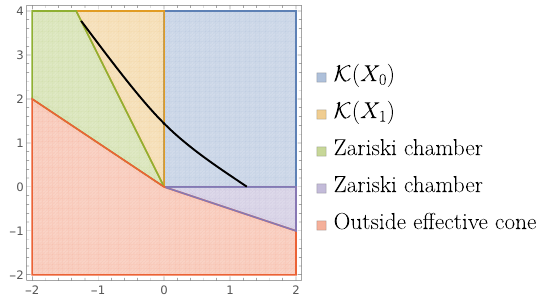
Figure 4 . Effective cone of the THCY example (4 , · ) , showing Kähler cones of CYs X 0 and X 1 , as well as two adjacent Zariski chambers, with a geodesic curve